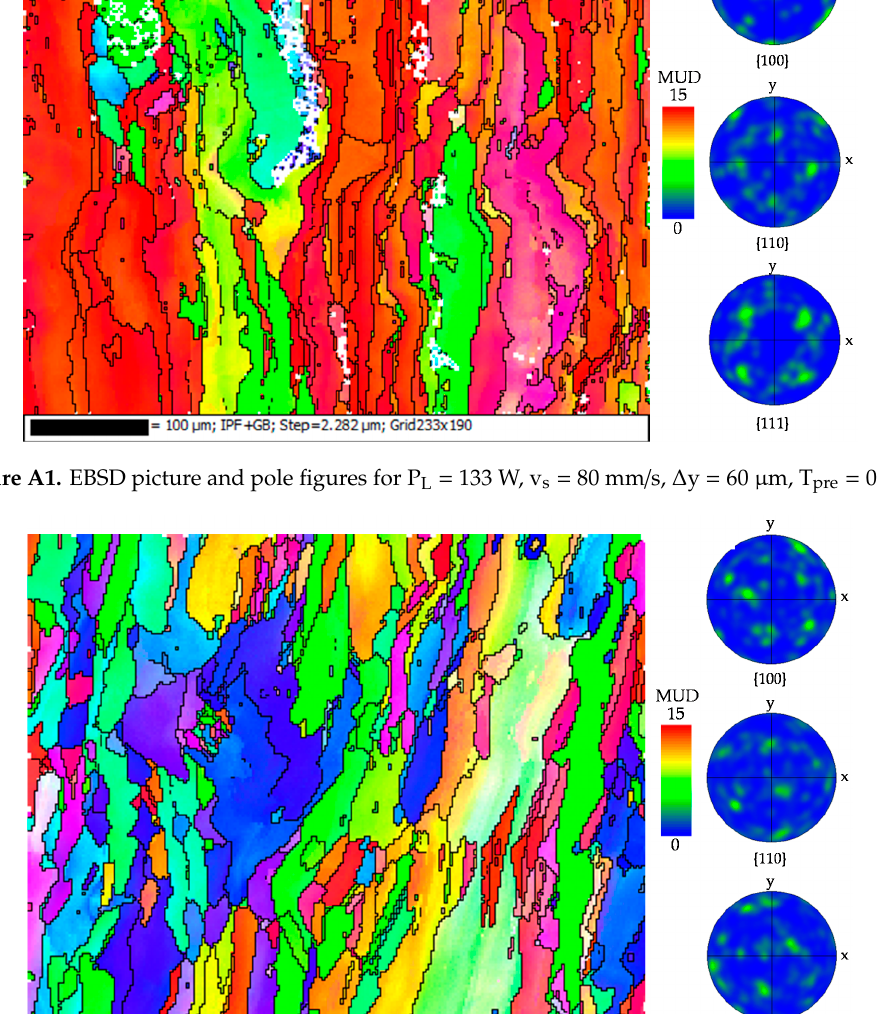
Figure A2. EBSD picture and pole figures for P L = 200 W, v s = 83.3 mm/s, Δ y = 70 µm, T pre = 0 °C.